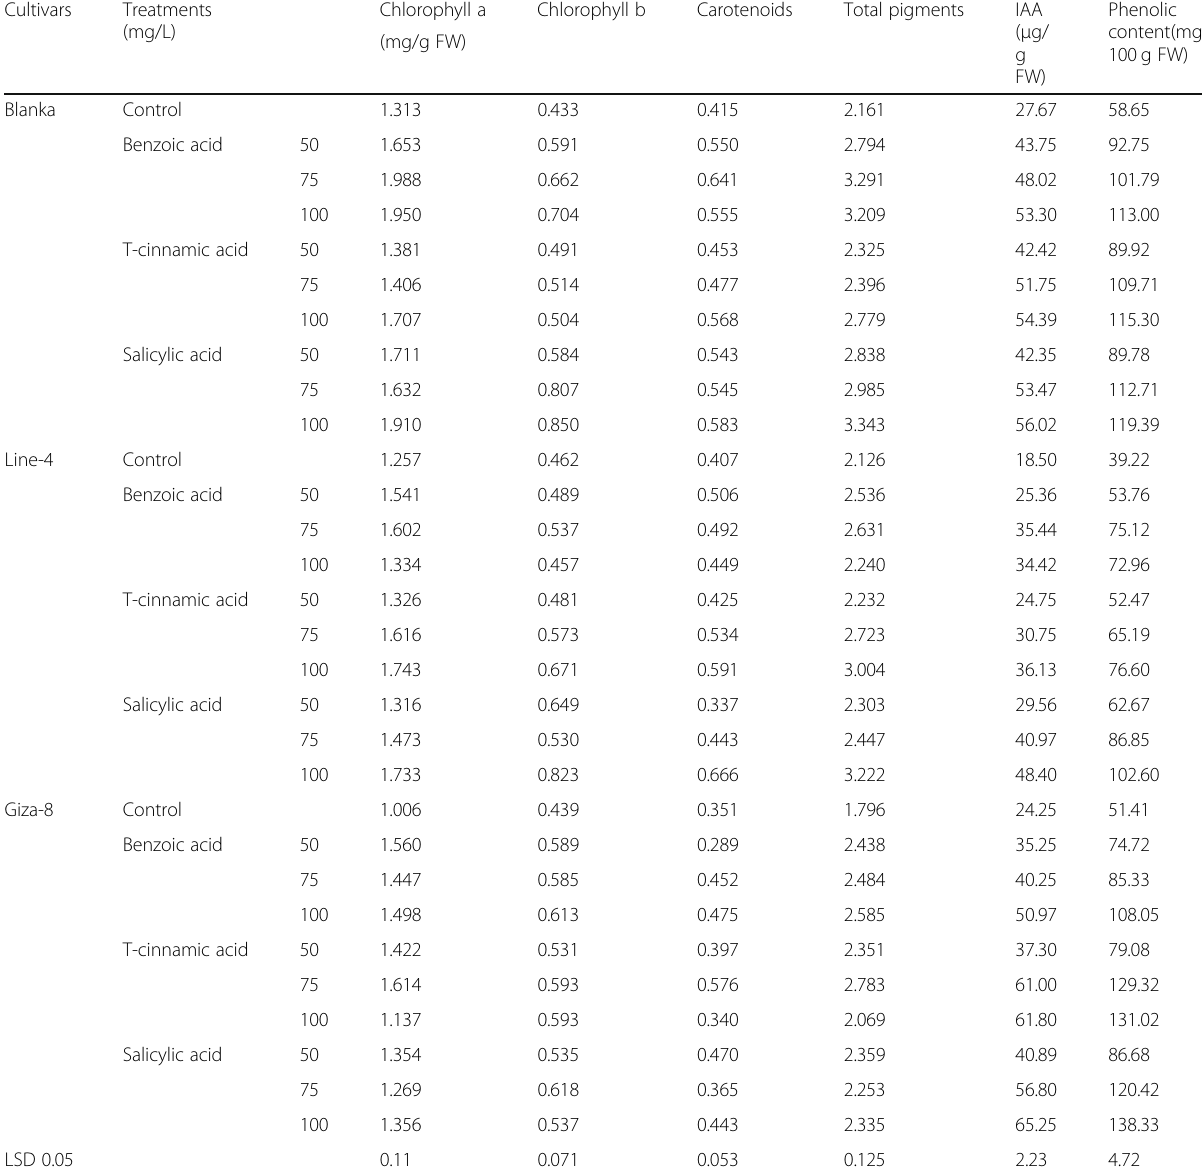
Table 21 Effect of interaction between benzoic, t-cinnamic and salicylic acids on photosynthetic pigments, IAA and phenolic contents of flax cultivars grown under sandy soil conditions (data are means of two successive seasons) Cultivars Treatments